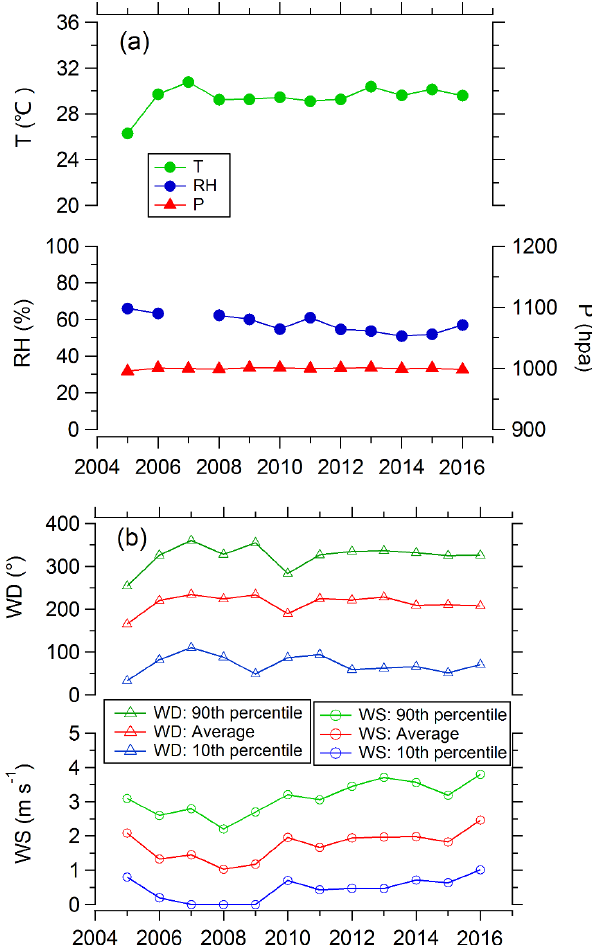
Figure 4. Variations in daytime (07:00–19:00) averages of mete- orological conditions including temperature ( T ), relative humidity (RH), wind direction (WD), and wind speed (WS) in Beijing in Au- gust during